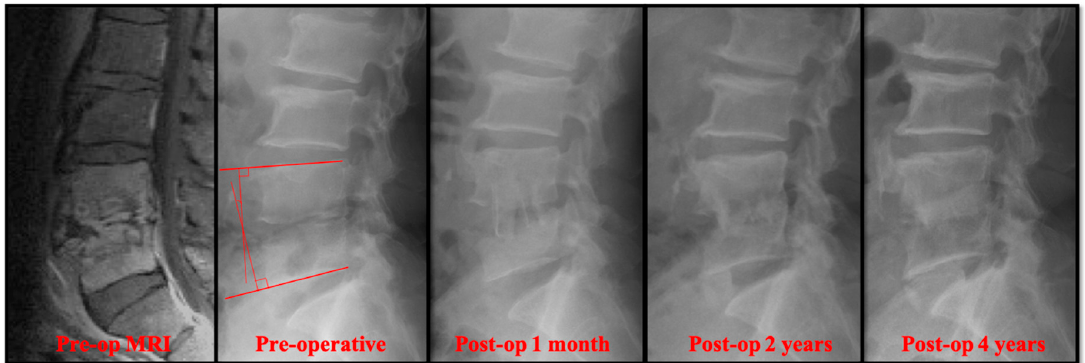
Figure 1. A 55-year-old man presented with severe pain in the lower back and was diagnosed with L4–L5 Escherichia coli infection. Four years after the traditional anterior open surgery, bony fusion was seen in the infected L4–L5 segment. The sagittal angle was measured by the angle of the perpendicular lines from the upper and the lower endplates.